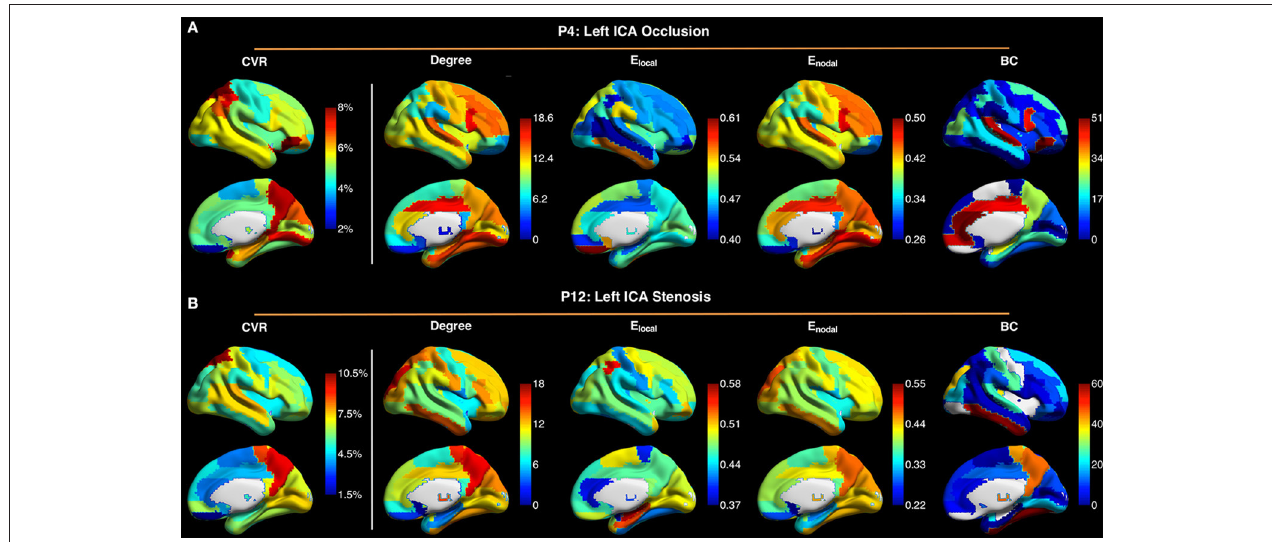
FIGURE 5 | Maps of cerebrovascular reactivity (CVR), degree, local efficiency E local , nodal efficiency E nodal , and betweenness centrality (BC) in the contralateral hemispheres in a patient with occlusion of left internal carotid artery (ICA) (P4) (A) , and in a patient with stenosis of the left ICA (P12) (B) . The CVR maps are similar to the maps of degree and E nodal . Connectivity sparsity was set to 40%.